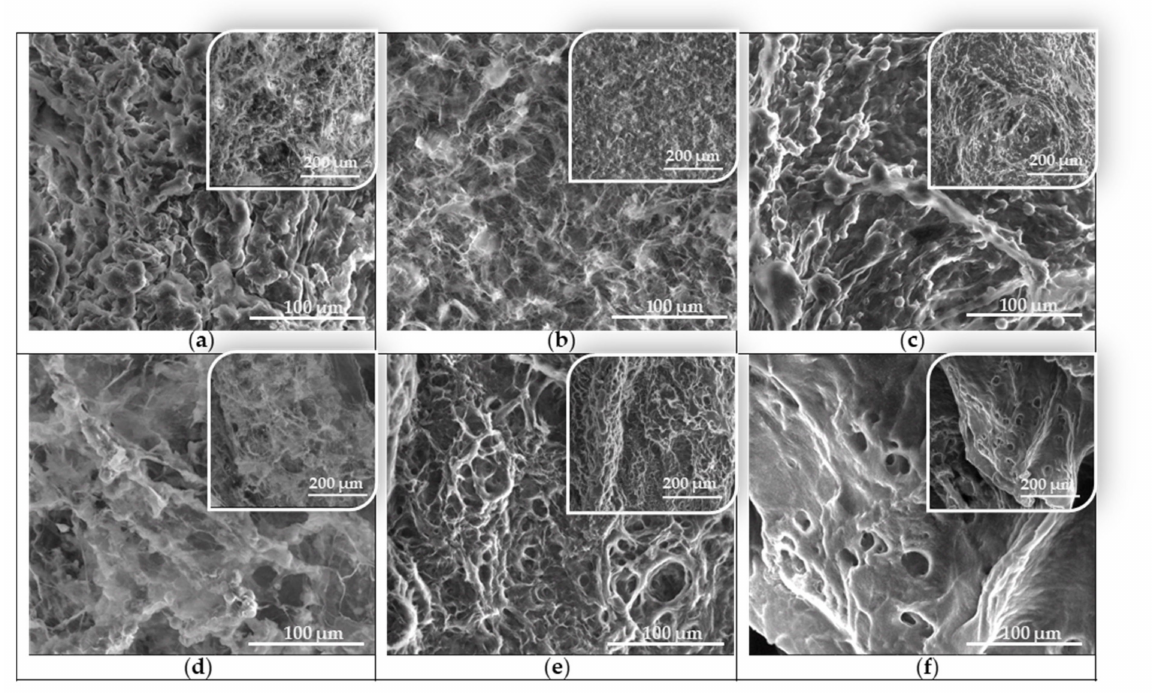
Figure 4. Scanning electron microscopy images of hydrogels at two different mag-